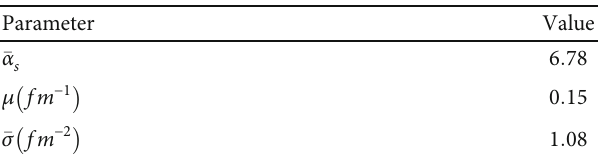
Figure 2: Wave function of baryons. Table 2: Fitted values of the